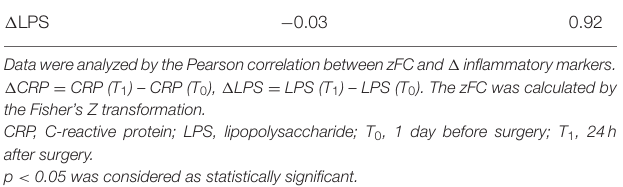
TABLE 6 | Correlation between FC and inflammatory markers.